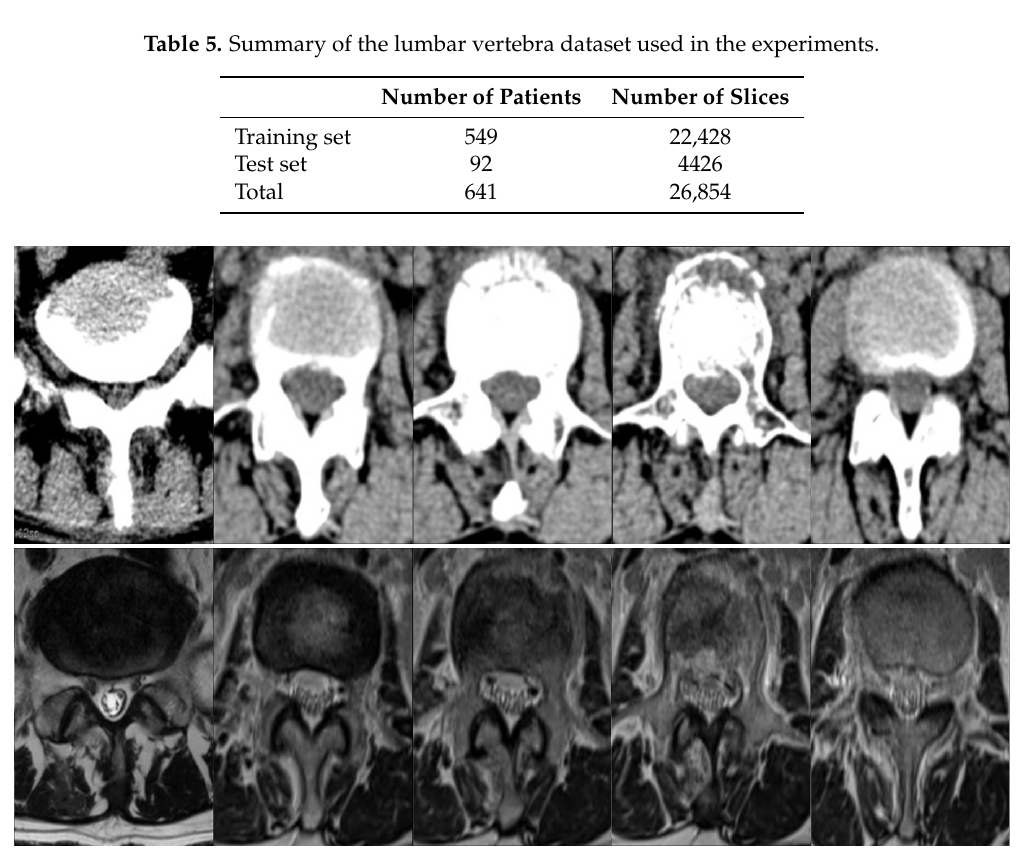
Figure 4. Sample images of axial lumbar vertebra CT (upper row) and MR images (lower